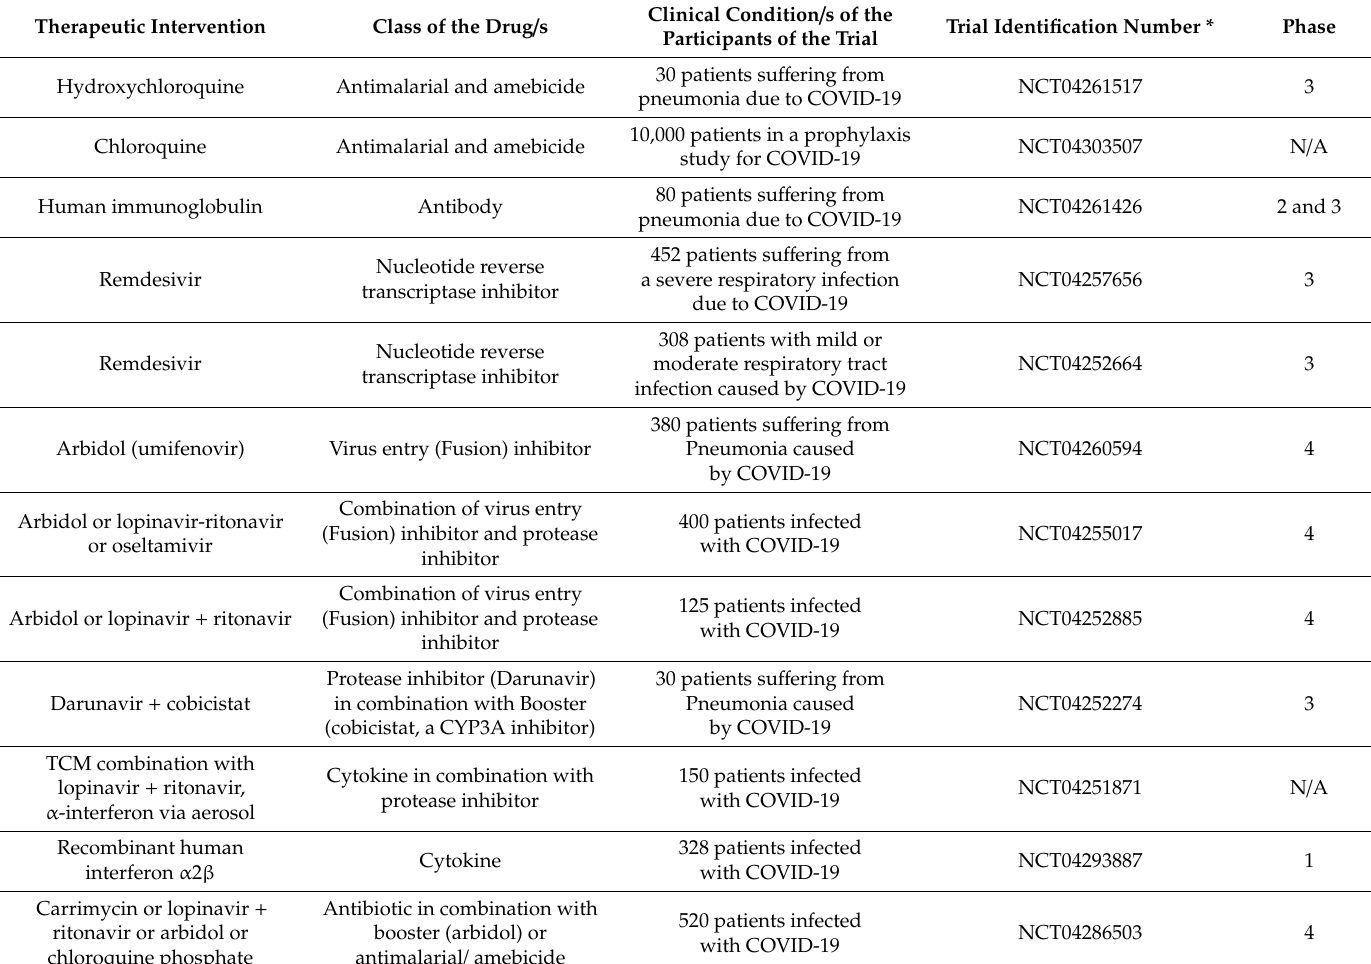
Table 3. Summary of drugs being repurposed in clinical trials against